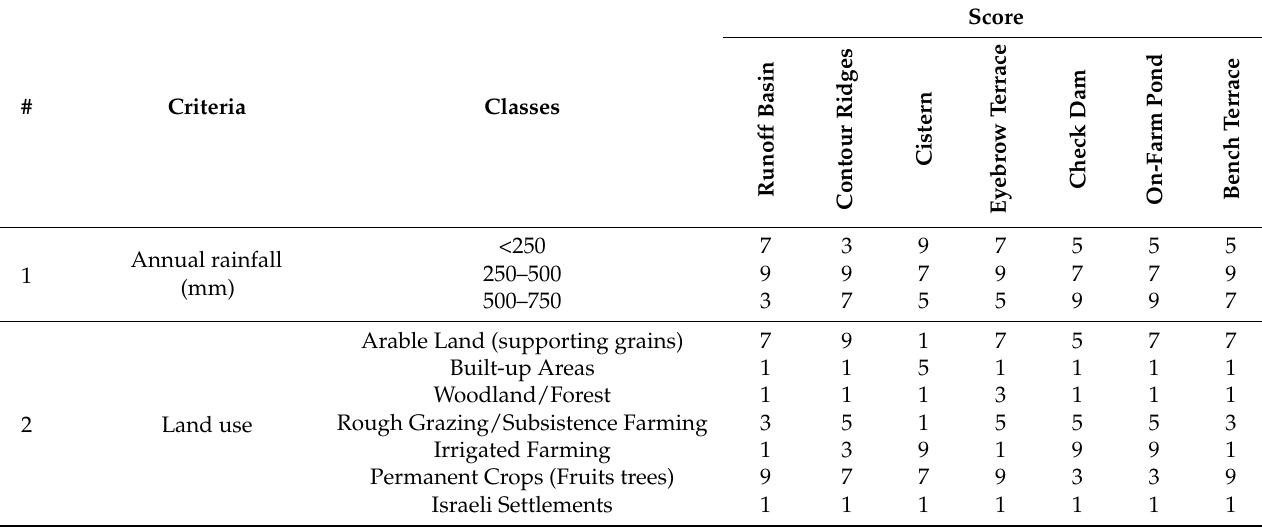
Table 1. The suitability score of the selected rainwater harvesting techniques for the West Bank, Palestine.